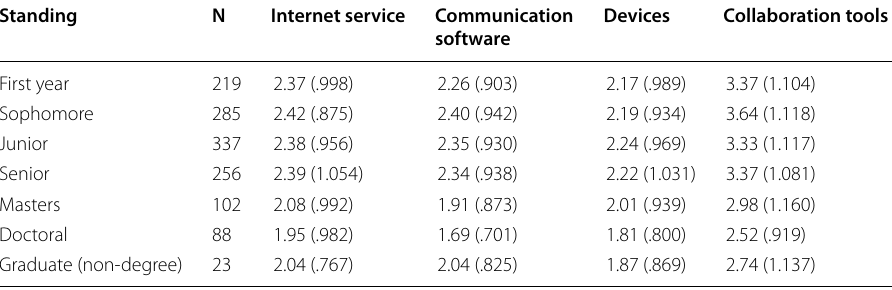
Table 6 Means (standard deviations) across class standing for the four access items Standing N